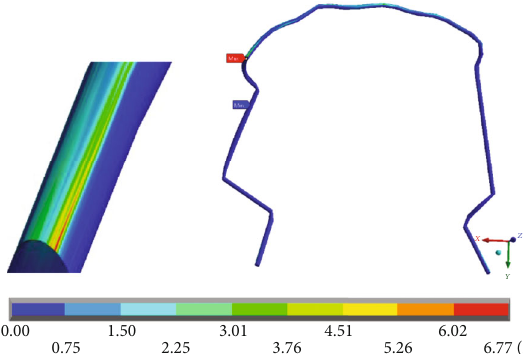
Figure 22: von Mises stresses on the wire. The red marker indicates the maximum stresses, and the blue marker indicates the minor stresses.